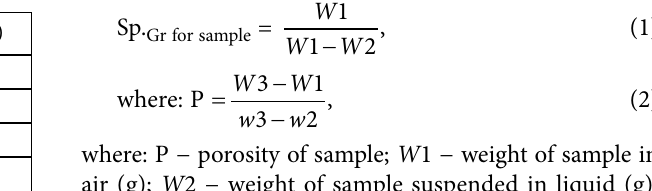
Table 1. The materials properties used as different powders